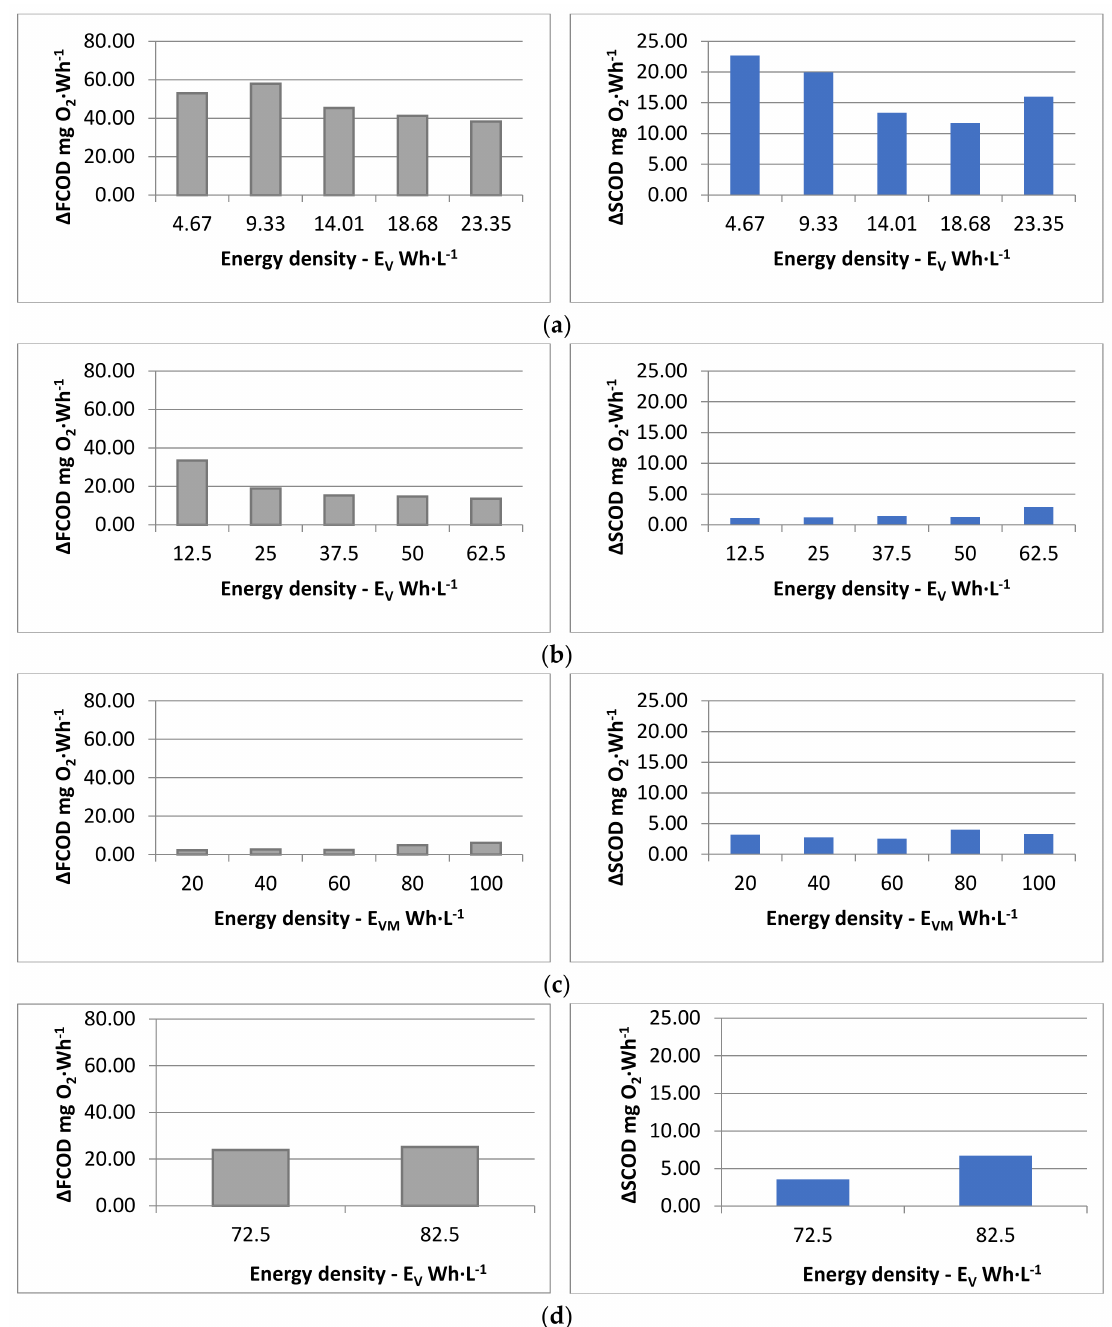
Figure 5. The indicators of efficiency ( ∆ FCOD and ∆ SCOD per energy unit) for various methods of disintegration—( a ) laboratory scale homogenising mixer; ( b ) semi-technical disintegrating mixer; ( c ) ultrasonic disintegration; ( d ) hybrid